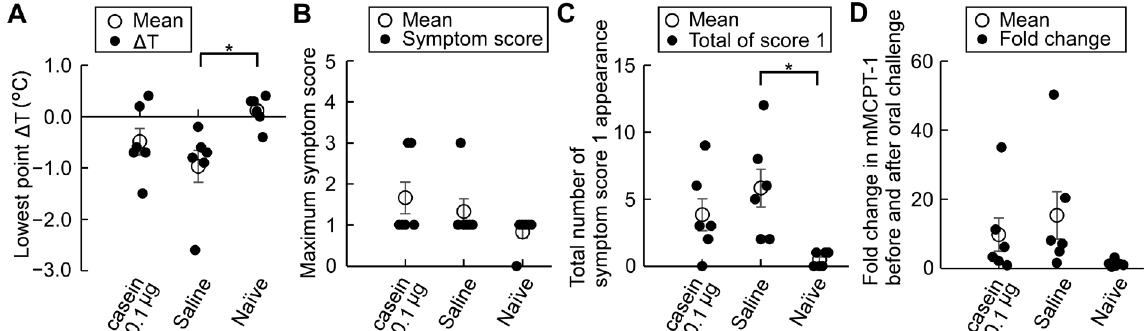
Figure 9. Effects of allergic symptoms after casein immunotherapy in adjuvant-free casein-sensitized allergy model mice. ( A ) Comparison of the lowest point ΔT and ( B ) the maximum symptom score after oral α -casein challenge with ASA pre-medication in casein- and saline-treated sensitized and naïve mice; ( C ) T otal number of recorded symptom score 1 after oral α -casein challenge in casein- and saline-treated sensitized and naïve mice; ( D ) Fold changes in serum mMCTP-1 levels after oral α -casein challenge. Serum samples were collected before on day 64 and after α -casein challenge on day 72 or 73 ( n = 6/group). Data are mean ± SEMs. * p < 0.05.